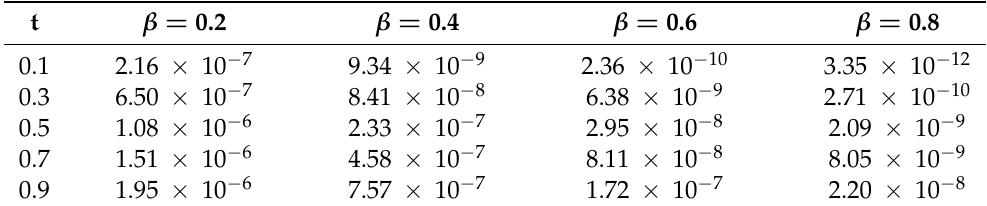
Table 6. Error analysis of LHPM in a fractional domain for a time-fractional Ito model (Example 2) when k = 0.14 and x =